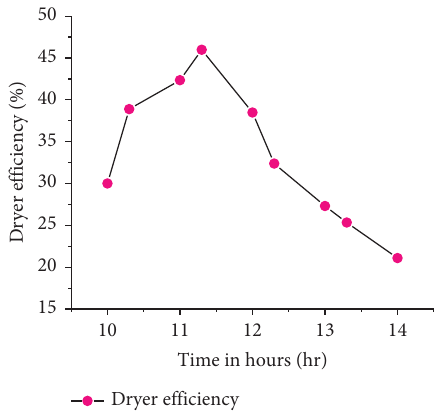
Figure 3: Dryer efciency curve for drying ginger.